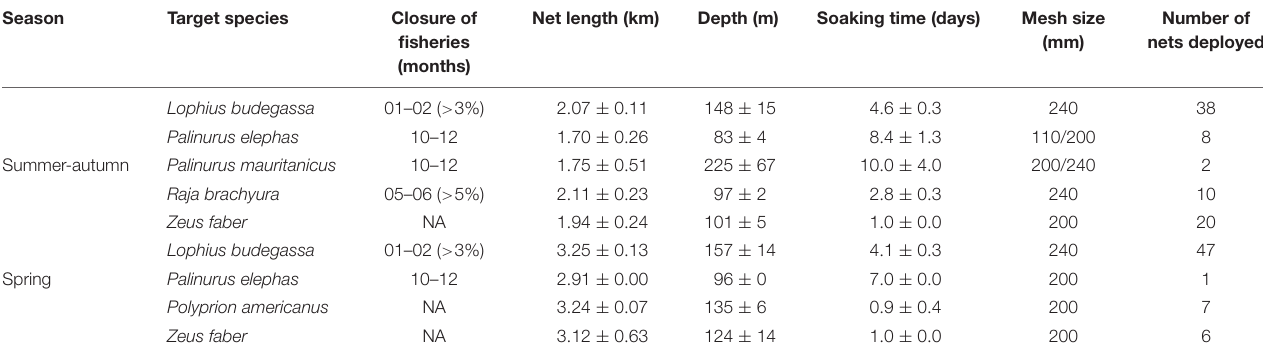
FIGURE 1 | Map of the study area off the coast of Sagres (southern Portugal) showing the transects of bottom-set gillnets used to document coral bycatch in circalittoral and deep-sea habitats. (A) Summer-autumn sampling season (1 September to 31 October) with inset showing the location of the study area in Portugal. (B) Spring sampling season (11 May to 5 June) with insets zooming on nets deployed following a zigzag course. Sets of gillnets are shown by target species (colors). Bathymetric isobaths are as follows: 50 m, 100–500 m (increments of 100 m), and > 500 m (increment of 200 m). TABLE 1 | Features of the target species métier (average ± standard error) of the bottom-set gillnets deployed during the documentation of coral bycatch in Sagres (southern Portugal) during the two seasons studied. Season Target